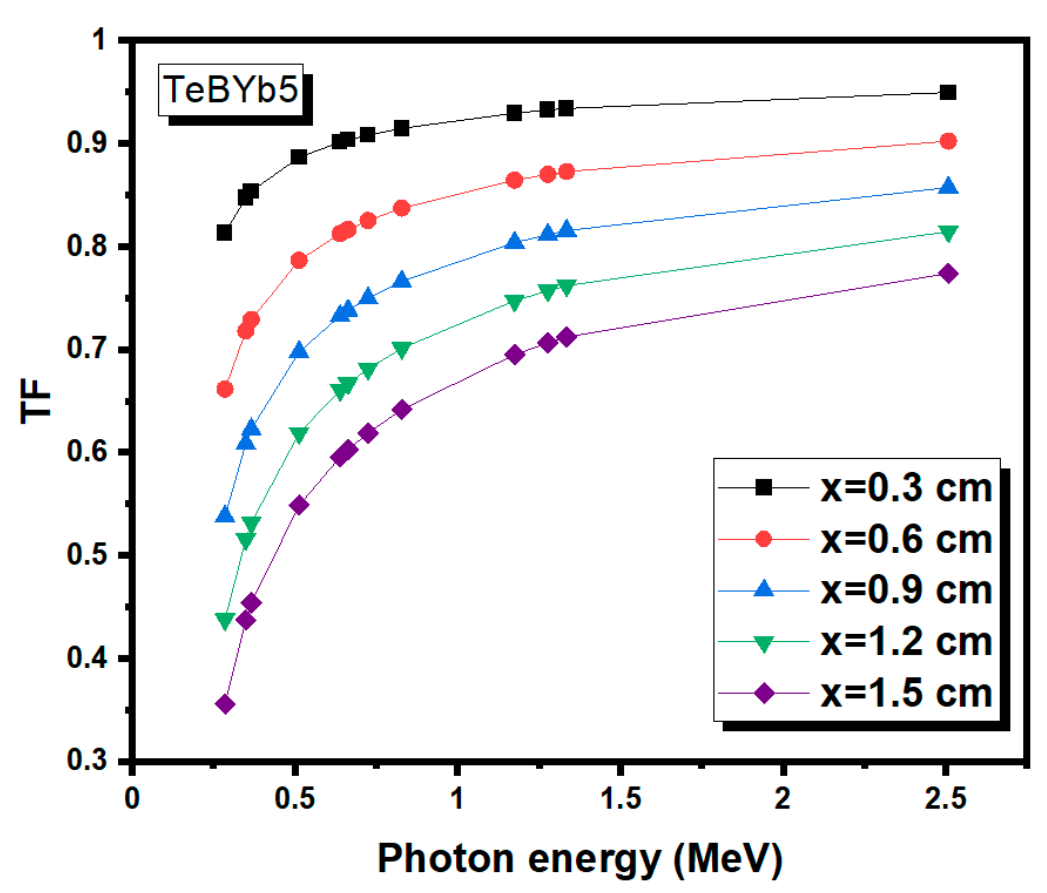
Figure 5. The transmission factor for TeBYb5 as a function of the energy at different thicknesses.